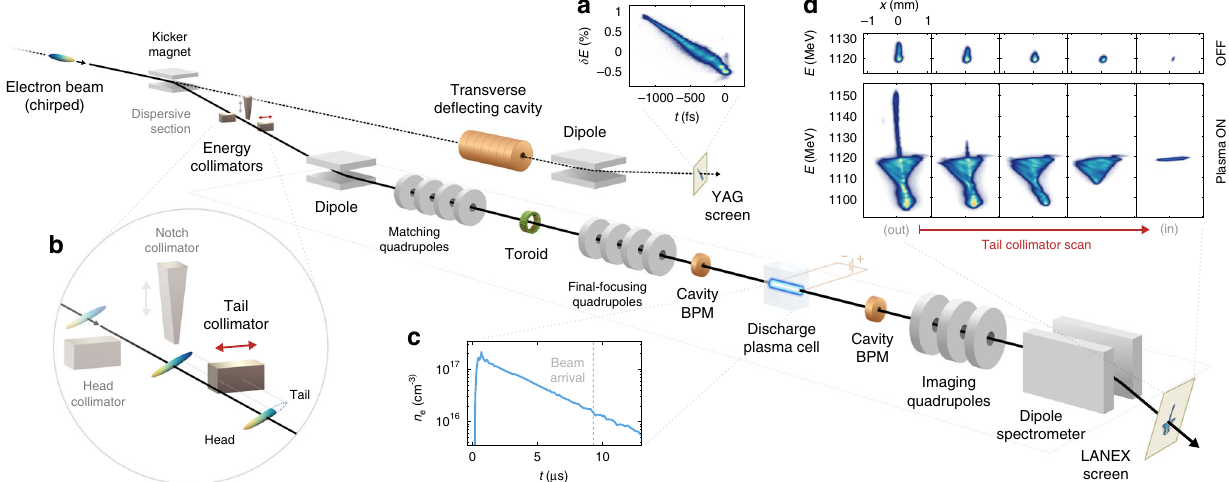
Fig. 2 Experimental setup. a An electron beam with a linearly chirped longitudinal phase space is characterised in a parallel beam line using a TDS. b A beam enters a dispersive section with energy collimators for optional removal of the tail (high energy), the head (low energy), and the centre (for two- bunch generation). The beam charge is measured with a toroid after collimation and before the beam is focused into a discharge plasma cell. c The relative time-of-arrival of the beam is adjusted to reach the desired plasma density: the temporal evolution of the average density was measured using two-colour interferometry in a test stand with a replica cell. d Finally, the beam following plasma interaction passes through a quadrupole triplet and is vertically dispersed by a spectrometer dipole to form a point-to-point image on a scintillating LANEX